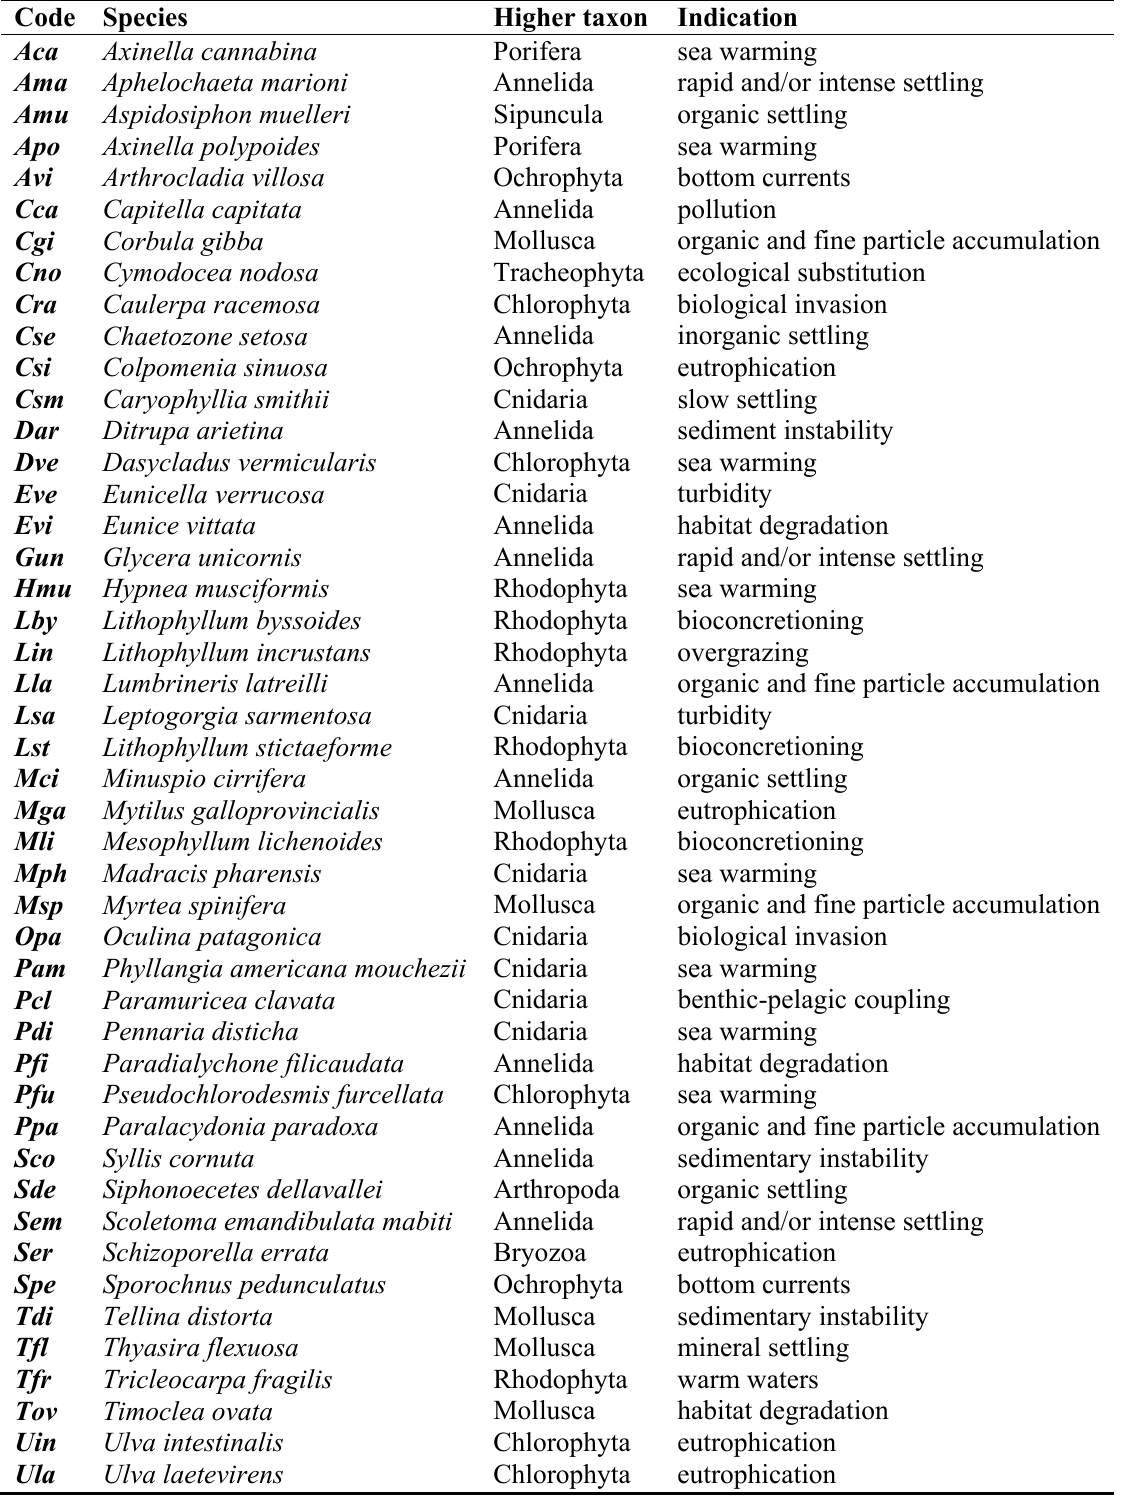
Table 2. List of the indicator species utilized for the map of degradation and risk of the marine territory of the MPA “Isola di Bergeggi,” which can be freely downloaded at full size from the SEAMap site [45]. The code with which the species occurrence is mapped, the Latin name of the species, the higher taxon to which it belongs, and the environmental information provided are reported left to right. Individual species do not necessarily occur in the same TU, thus indicating different environmental conditions in different parts of the